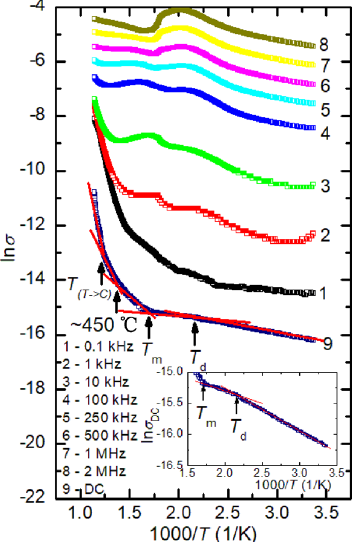
Fig. 6 Electrical conductivity of the investigated NBT ceramics as a function of 1000/ T for various frequencies. The temperature T ( T- > C ) denotes the change from tetragonal to cubic symmetry. Inset: magnified section showing two linear dependences in the following ranges of low temperatures: (1) RT– T d and (2) T d – T m